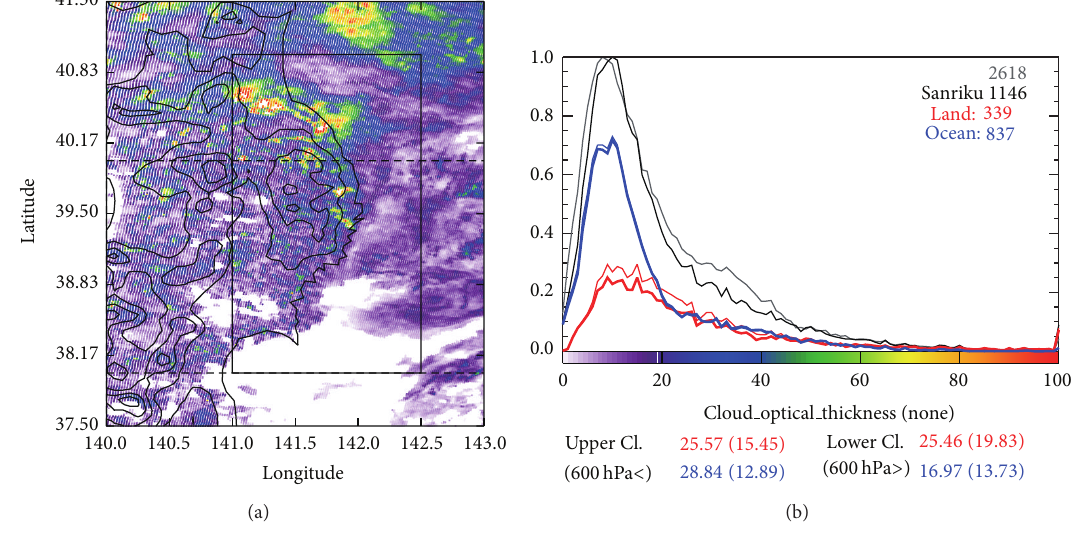
Figure 13: Same as Figure 9 but at 0150 UTC July 16,